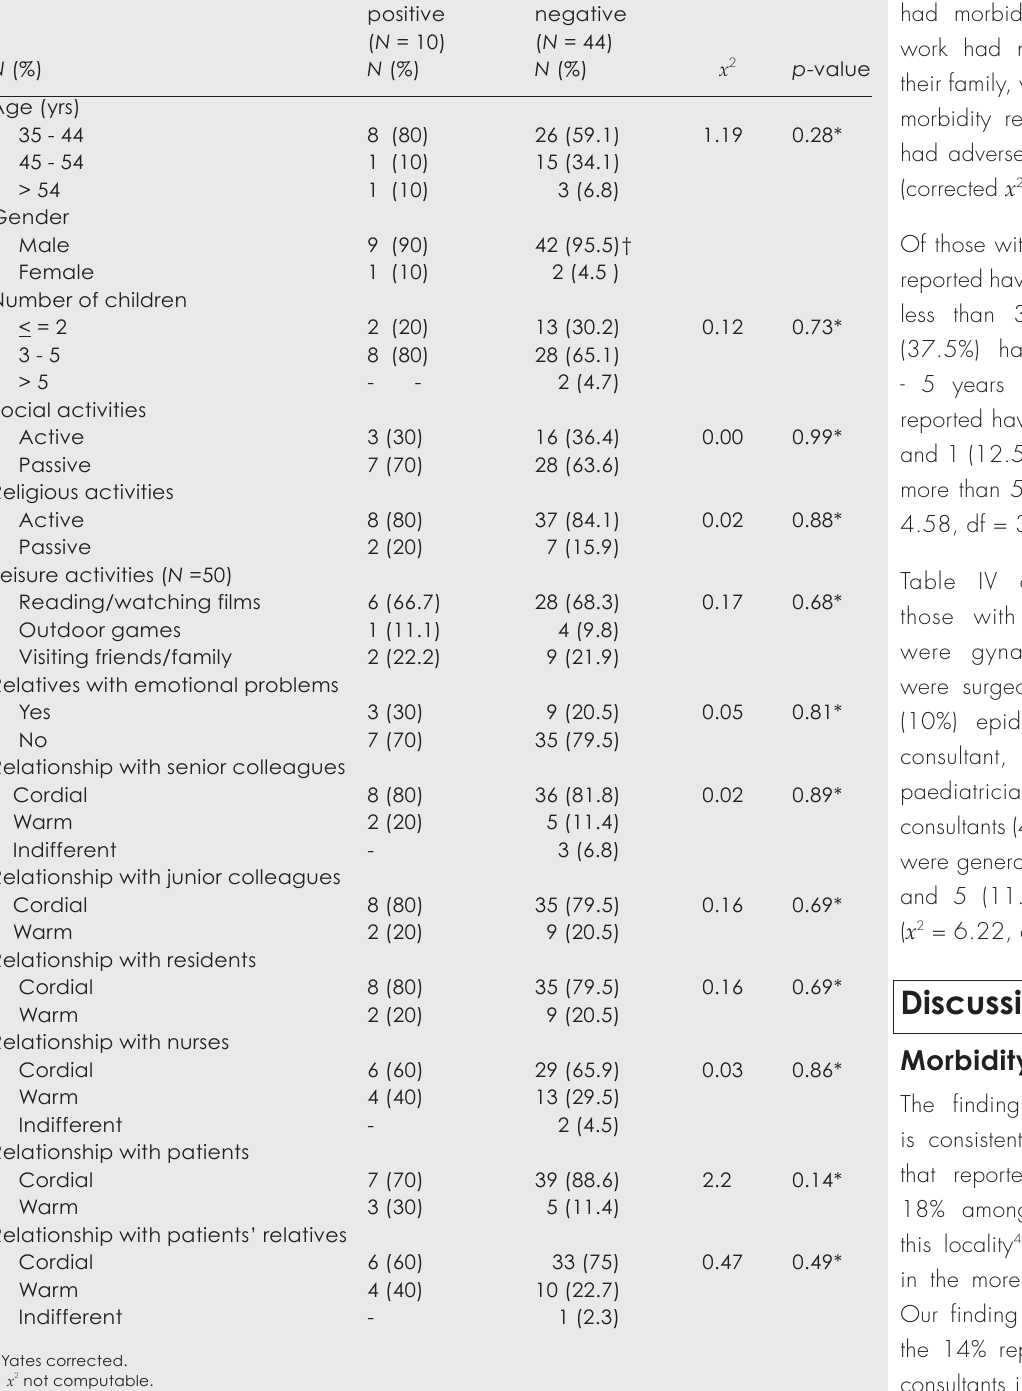
Table III. Sociodemographic factors of GHQ-positive and GHQ-negative